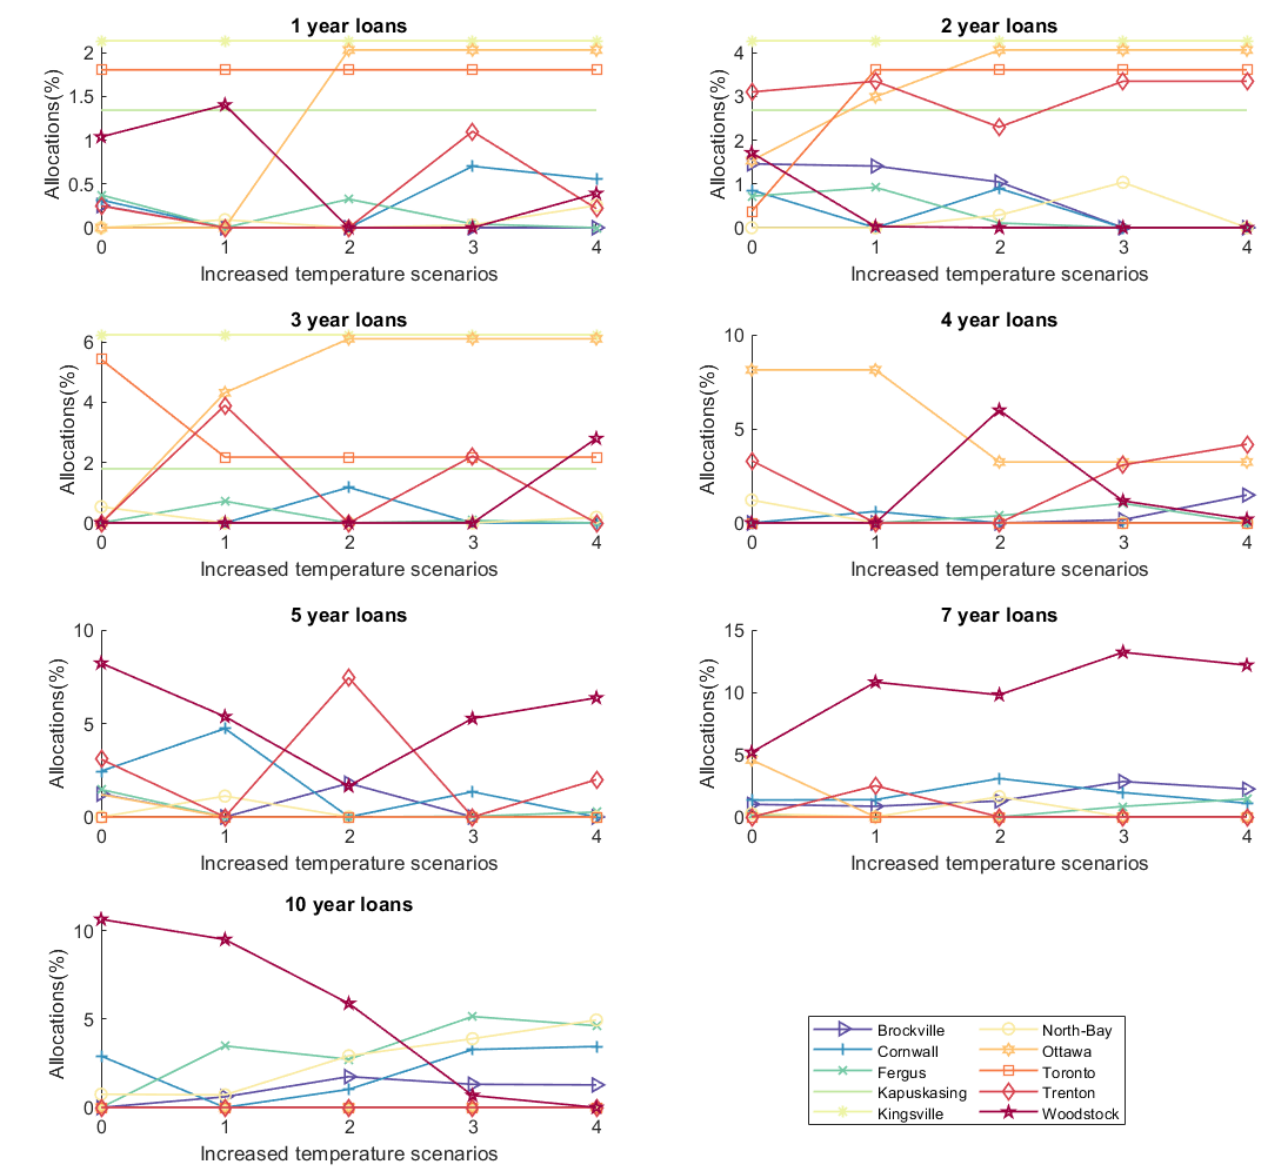
Figure 10. Allocations to each tenor of loan in each region under five different 1 ◦ C increased temperature